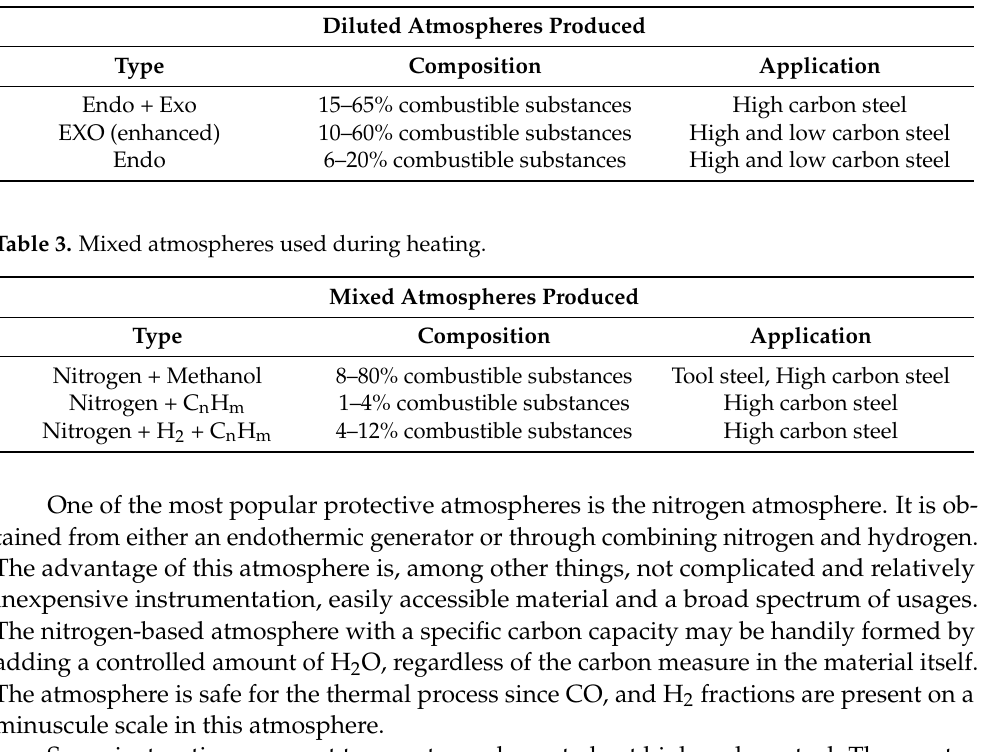
Table 2. Diluted atmospheres used during heating.